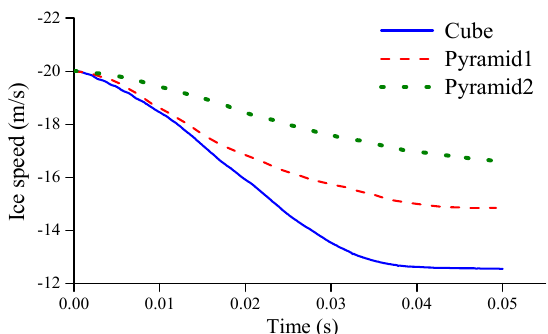
Figure 28. Time series of ice load Fx and Mx based on simulations with different ice blocks. ( a )The Fx with different ice blocks. ( b ) The Mx with different ice blocks .